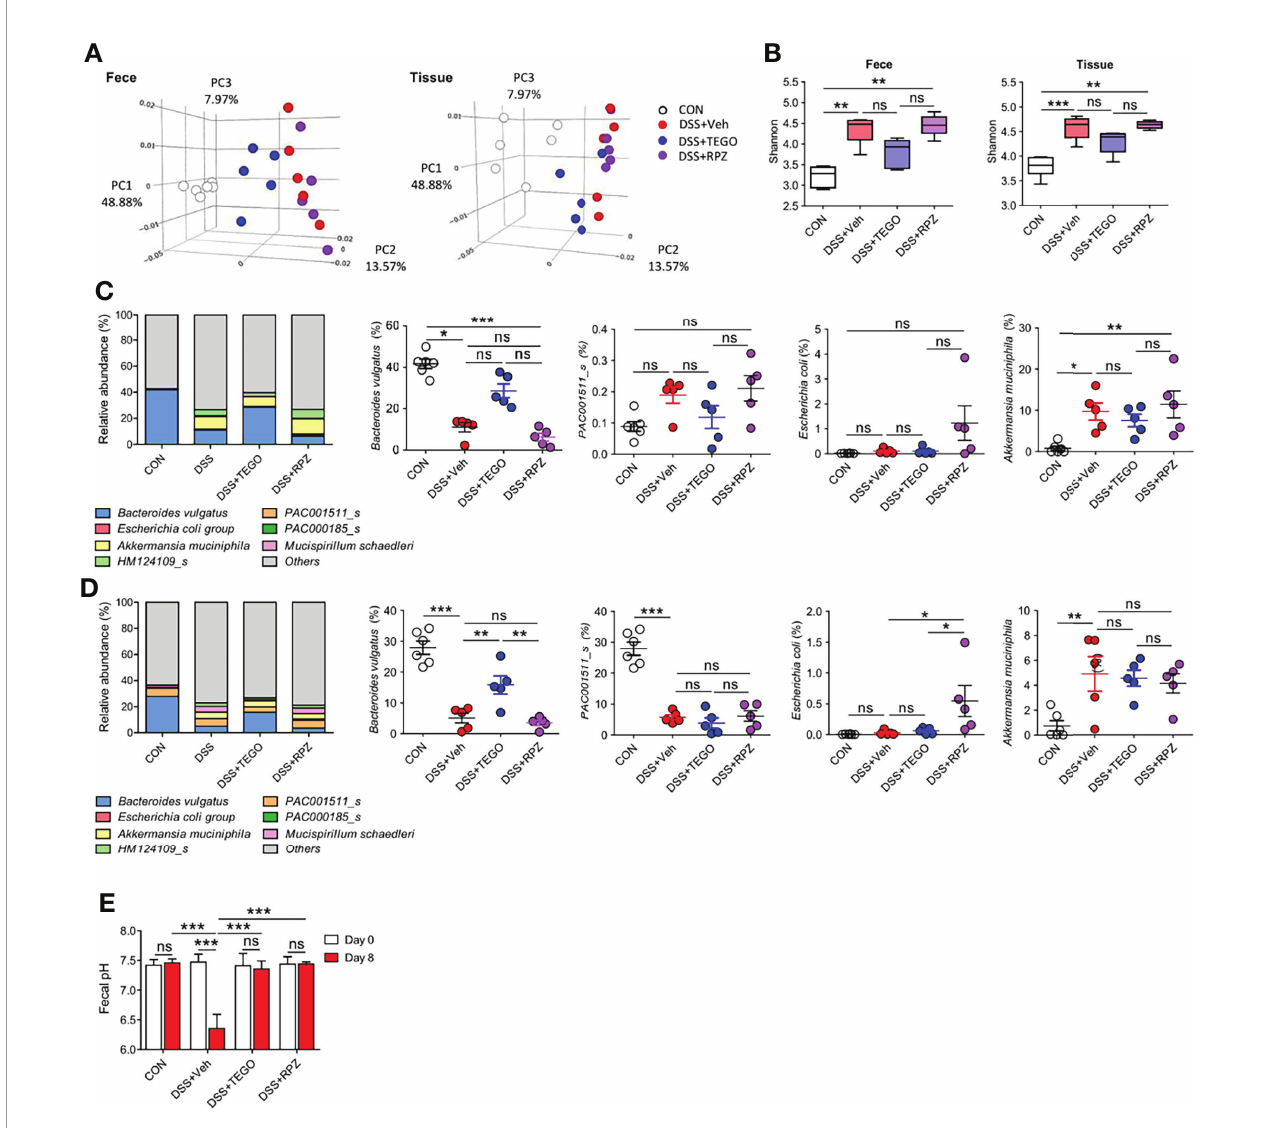
FIGURE 4 | Tegoprazan alters microbiota and prevents dysbiosis in colitis. Gut microbiome composition in feces and tissue was investigated using 16S rRNA sequencing: CON (n = 6), DSS+Veh, DSS+TEGO, and DSS+RPZ (each n = 5). (A – C) Effect of tegoprazan on beta (A) and alpha diversity (B) indices in DSS-induced colitis. (A) Principal coordinate analysis (PCoA). (B) Shannon index. Box plots with median, 25th/75th percentiles and whiskers from minimum to maximum, and individual values plotted. (C, D) Microbial community bar plot by species in fecal (C) and tissue (D) samples and the abundance ratio of Bacteroides vulgatus , PAC001511_s , Escherichia coli , and Akkermansia muciniphila . (E) Fecal pH: DSS+RPZ (n = 5), CON, DSS+Veh, and DSS+TEGO (each n = 4). Data represent the mean or mean ± standard error of the mean (S.E.M). Signi fi cance is indicated by * p < 0.05, ** p < 0.01, and *** p < 0.001 using one-way ANOVA followed by Dunnett ’ s multiple comparison test. ns, not signi fi cant; CON, normal control; DSS, treated with dextran sulfate sodium; Veh, treated with vehicle; TEGO, treated with tegoprazan; RPZ, treated with